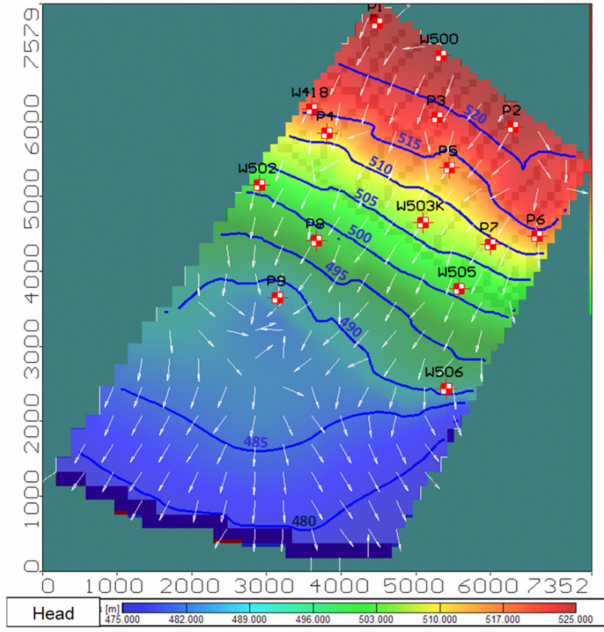
Figure 9. Groundwater head contours and flow path, 15 July 2017. The water-saving and groundwater salinity balance datasets were obtained from groundwater level and soil salinity field observations [5]. In the middle of the growing season (15 July 2017), the irrigation infiltration losses began overlapping with the overall groundwater flow. The drain effect began to appear in the drainage system’s upper part, as indicated by a flow path direction change in the map (Figure 9). The groundwater level depth decreased significantly in the middle of the growing season to 3–5 m from the soil surface (Figure 10). The groundwater level rise was uneven owing to different crop irrigation intensities. The maximal groundwater level increase was observed in sugar beet and onion fields, where the groundwater level rose to a depth of 2.5–3.5 m from the soil surface.